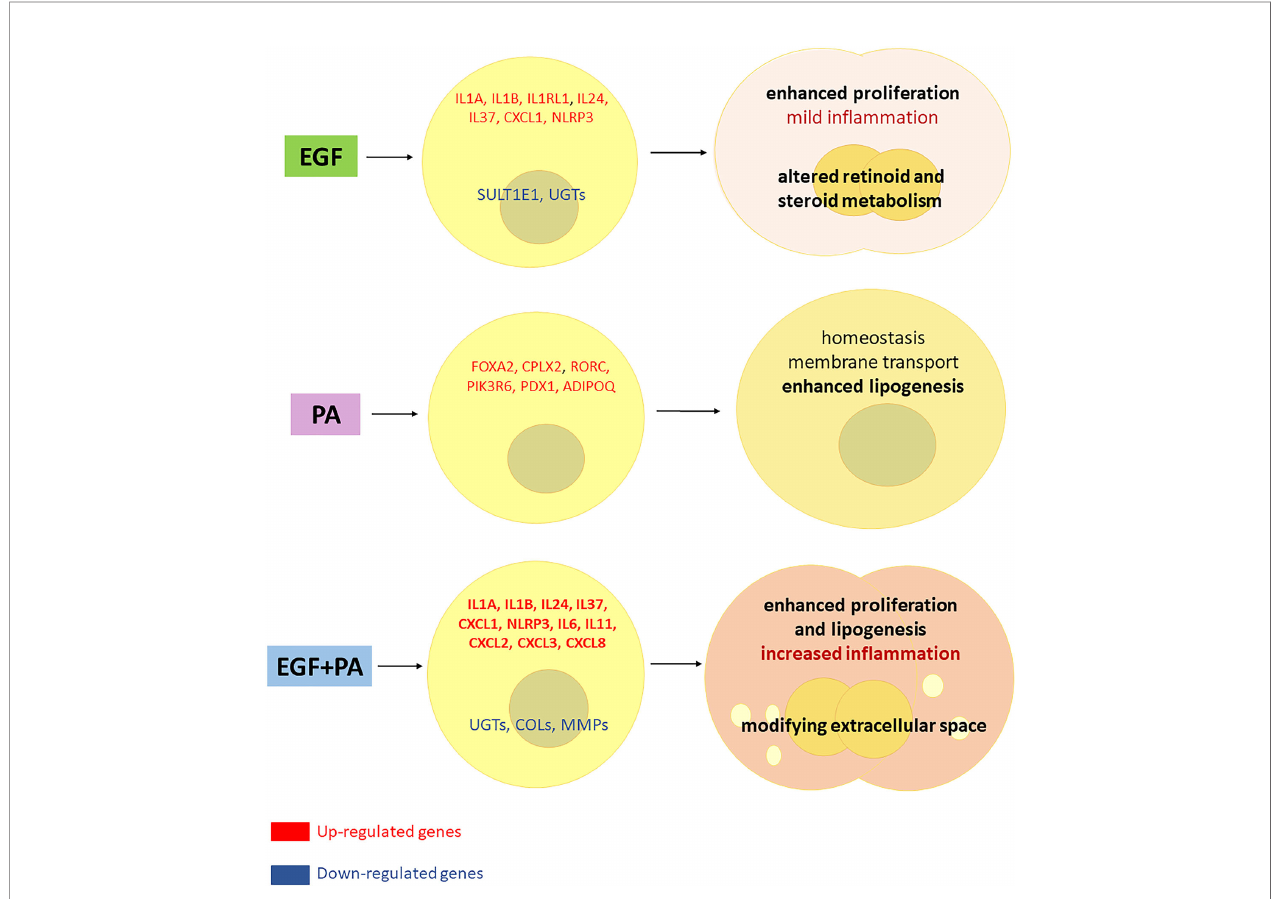
FIGURE 8 | Interaction between EGF and PA to modulate cell proliferation, lipogenesis and in fl ammatory responses in sebocytes. Based on our results, EGF induces proliferation and in fl ammatory pathways in sebocytes while down regulates the expression of genes involved in steroid and retinoid metabolism. PA treatment regulates lipogenesis and induces genes related to cell homeostasis in human sebocytes. When both EGF and PA is present, sebocytes exert an increased proliferation, lipogenesis and a prominent up-regulation of in fl ammatory genes, while genes involved in the extracellular matrix formation are down- regulated, which may have (patho)physiological relevance in shaping the in fl ammatory dermal